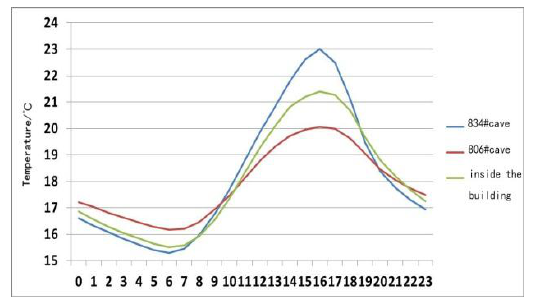
Figure 3 Time by time comparison of large data of temperature inside and outside the experimental structure